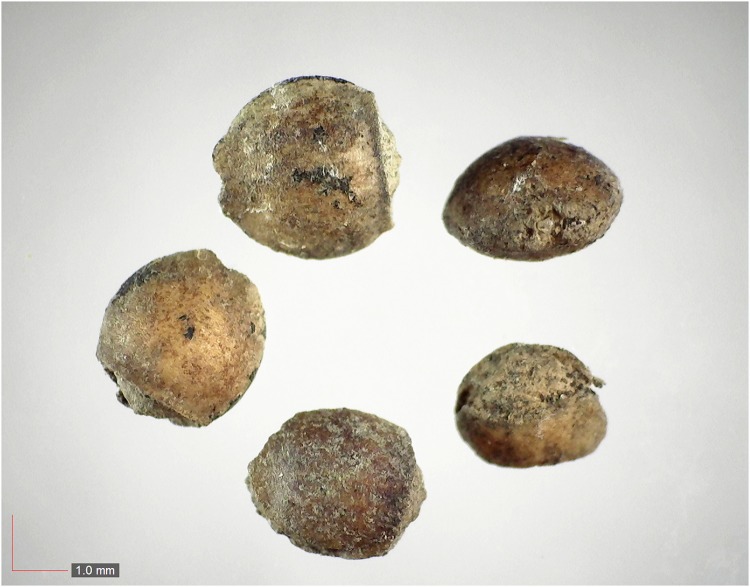
Unidentified 8.Table 2.